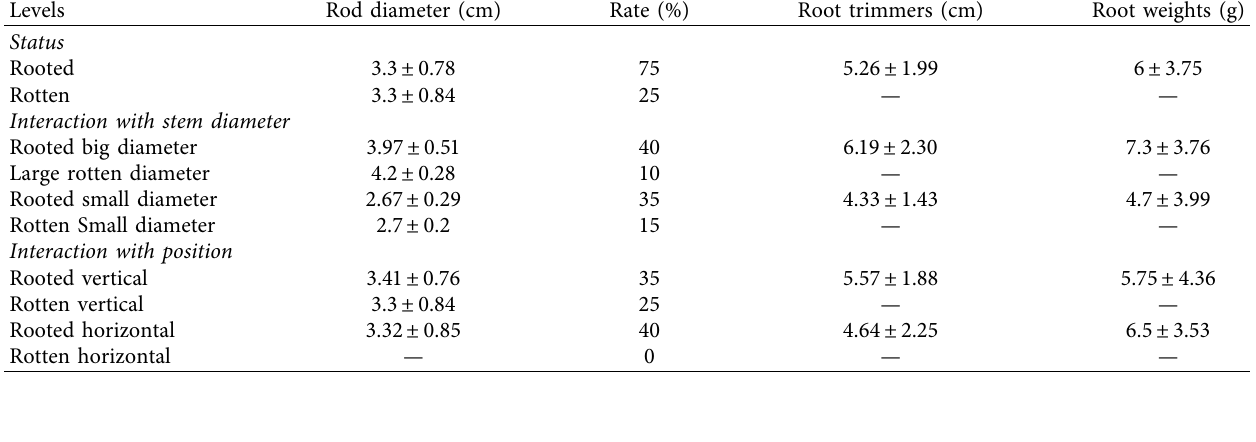
Table 2: Characteristics of the layers after skinning of Balanites aegyptiaca at the Regional Centre for Agricultural Research (CERRA), Maradi, Niger.